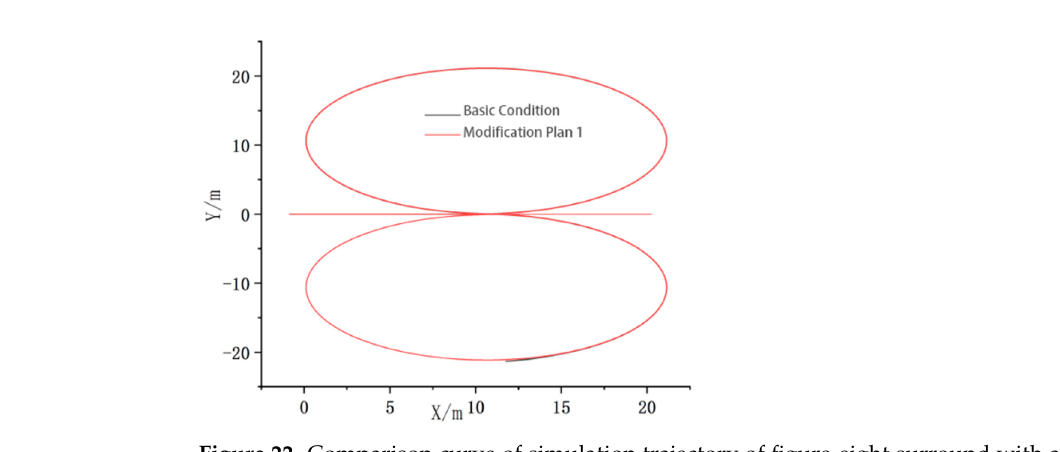
Figure 22. Comparison curve of simulation trajectory of figure-eight surround with aerodynamic parameters modification.